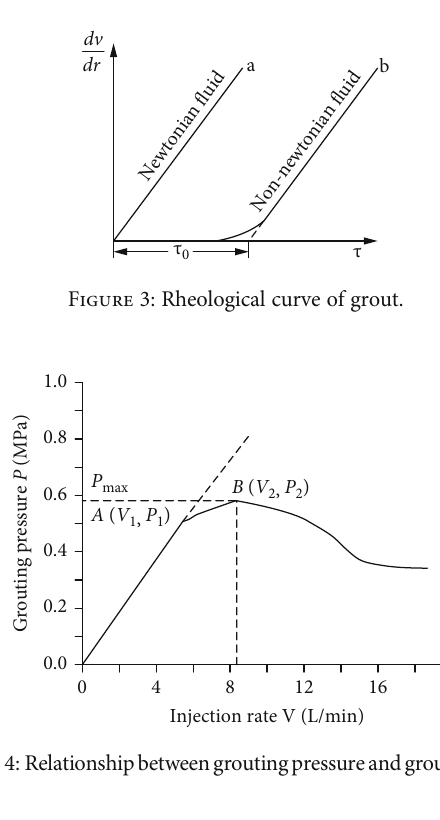
Figure 2: Rock mass model of collapsed rock mass not fi lled with goaf in horizontal coal seam mining.